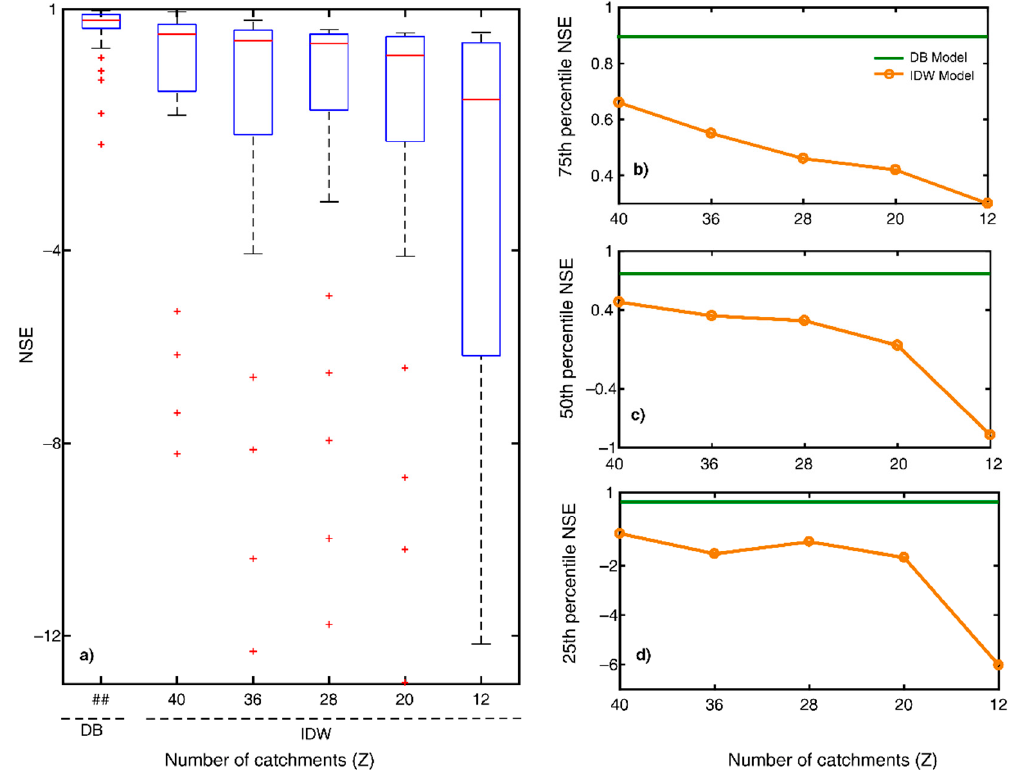
Figure 6. Plots in this figure show the sensitivity of the IDW model’s performance ( 𝑁𝑆𝐸 (cid:3010)(cid:3005)(cid:3024),(cid:3027) ) to discharge data scarcity. ( a ) Box plots of NSE IDW , Z s for di ff erent values of Z , the number of gauged basins randomly selected for implementing the IDW model, considering results from all 40 study basins. For a comparison, the box plot also shows NSE DB for the 40 study basins. The symbol ## in ( a ) corresponds to the fact that the DB model’s performance does not depend on Z . The remaining three plots show how the 75th percentile ( b ), 50th percentile ( c ) and 25th percentile ( d ) NSE IDW , Zs decline with Z (orange line). For comparison, each plot displays the corresponding values for the DB model (green lines). Overall, the figure suggests that regionalization models are unreliable in discharge data-scarce situations and that a calibration-free rainfall-runo ff model may be used in such situations.